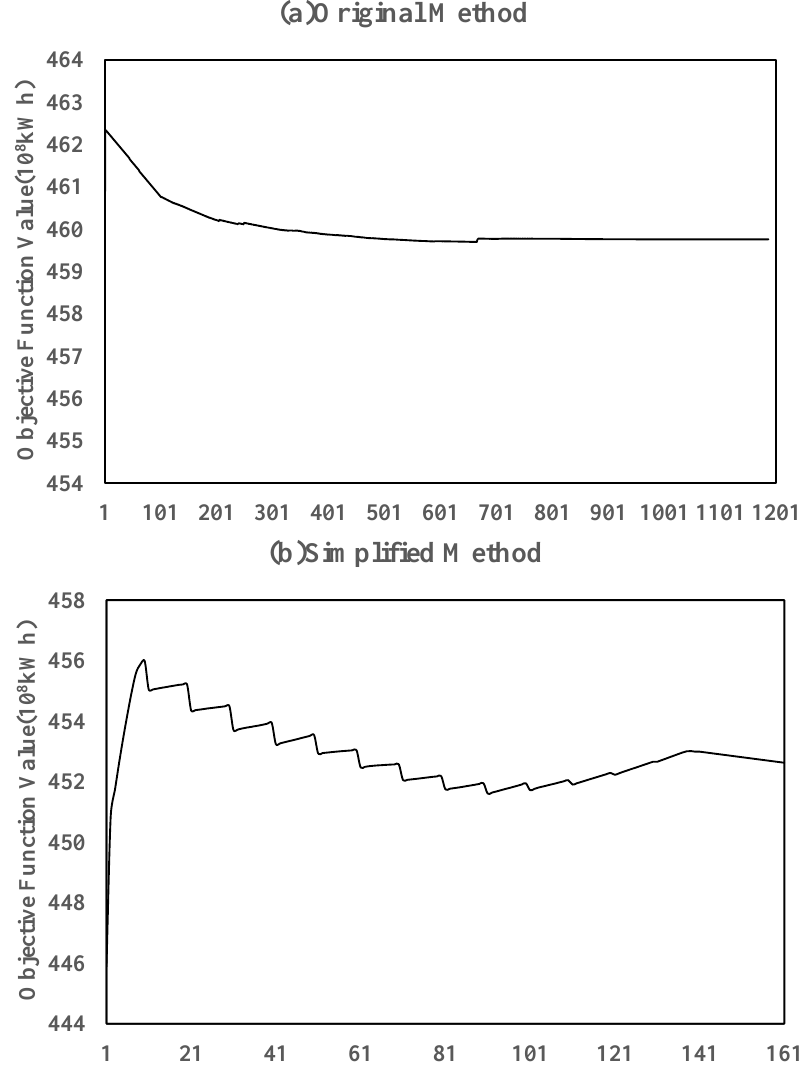
Figure 2. Objective Function Value Iteration Process of Original Method and Simplified Method.